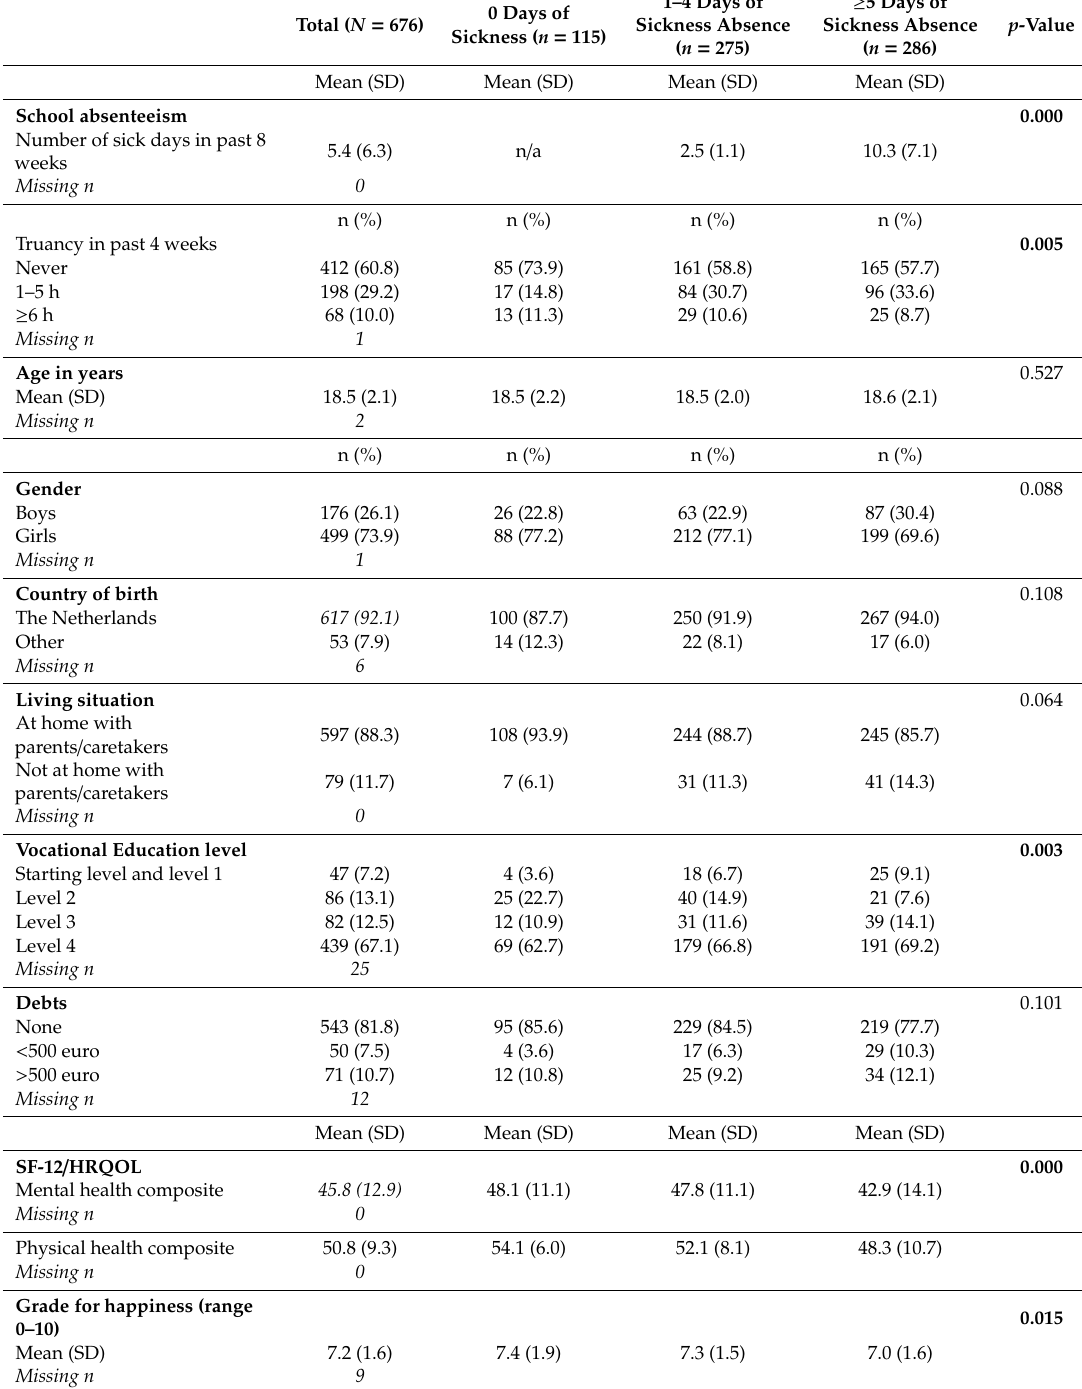
Table 1. General characteristics, quality of life and happiness of the participants ( N =